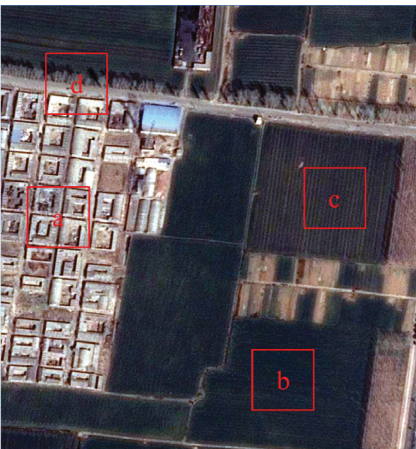
Figure 4: Experimental image. (a) House. (b) Farmland_1. (c) Farmland_2. (d) Mixed object.